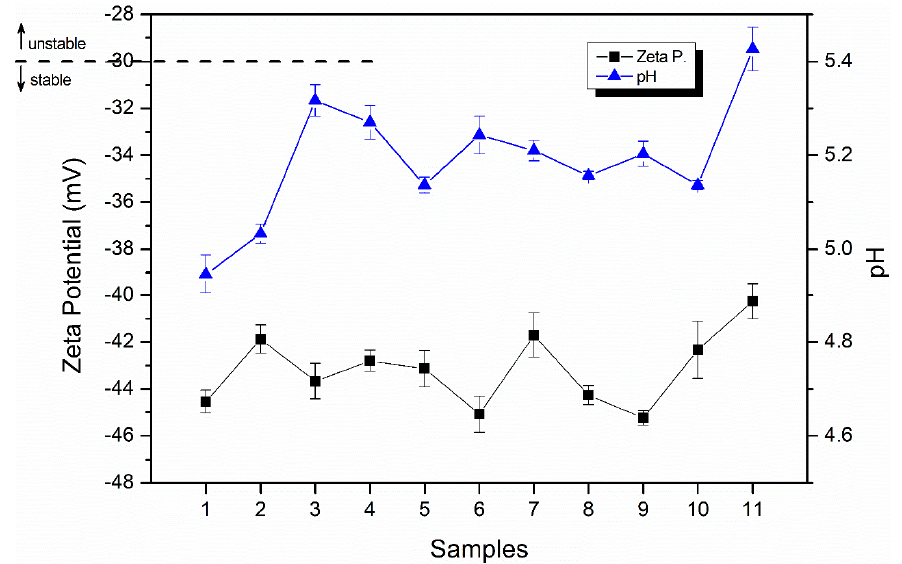
Figure 3. Zeta potential and pH values in the different samples.